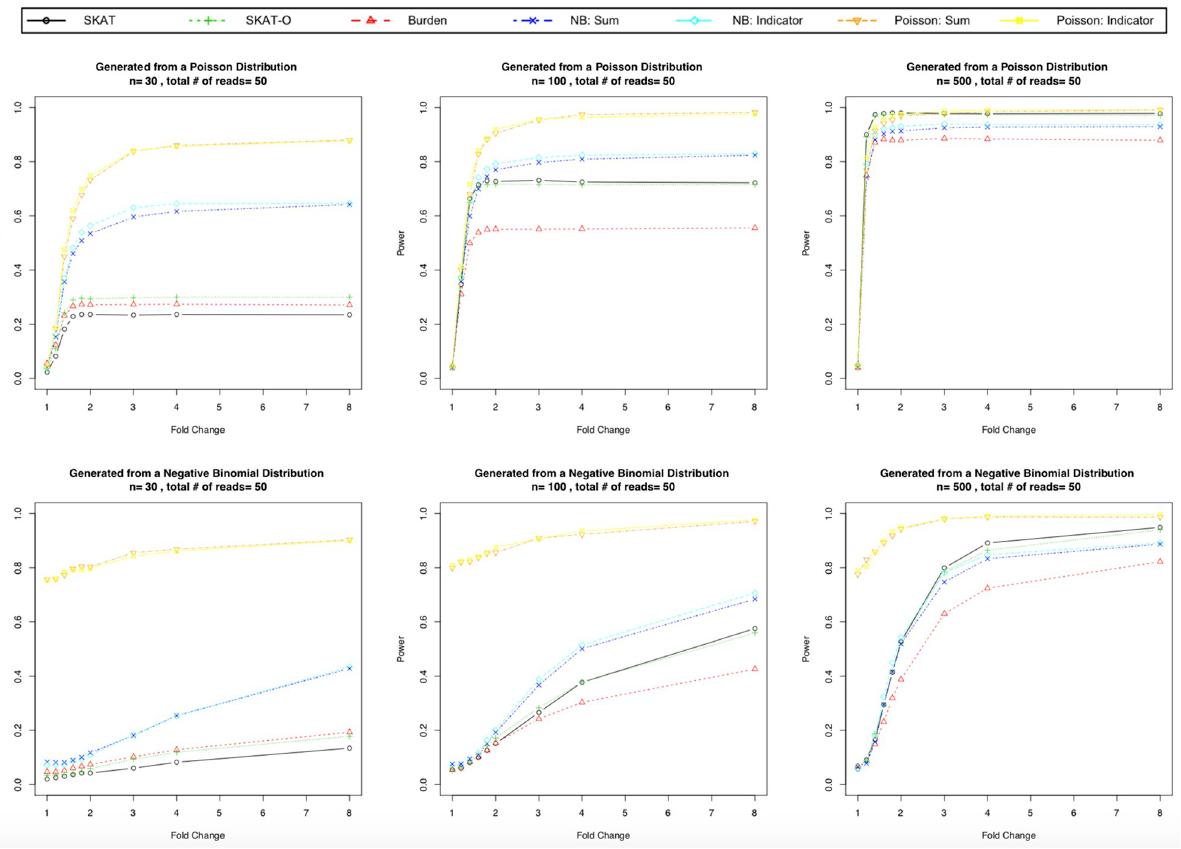
Fig 1. Simulation results for Scenario A. The read counts were generated from a Poisson distribution for row 1 and a negative binomial distribution for row 2. All plots were generated from Scenario A with the average number of reads μ = 50. Columns 1-3 are for 30, 100, and 500 subjects, respectively. For data generated under the Poisson distribution (row 1), all methods preserved the type 1 error rate (Fold Change = 1) and the Poisson regressions had substantial gains in power over the other methods for smaller sample sizes ( n = 30, 100). For data generated under the negative binomial distribution (row 2), the Poisson regressions had an inflated type 1 error rate (Fold Change = 1). For a sample size of 500, SKAT and SKAT-O had the highest power.